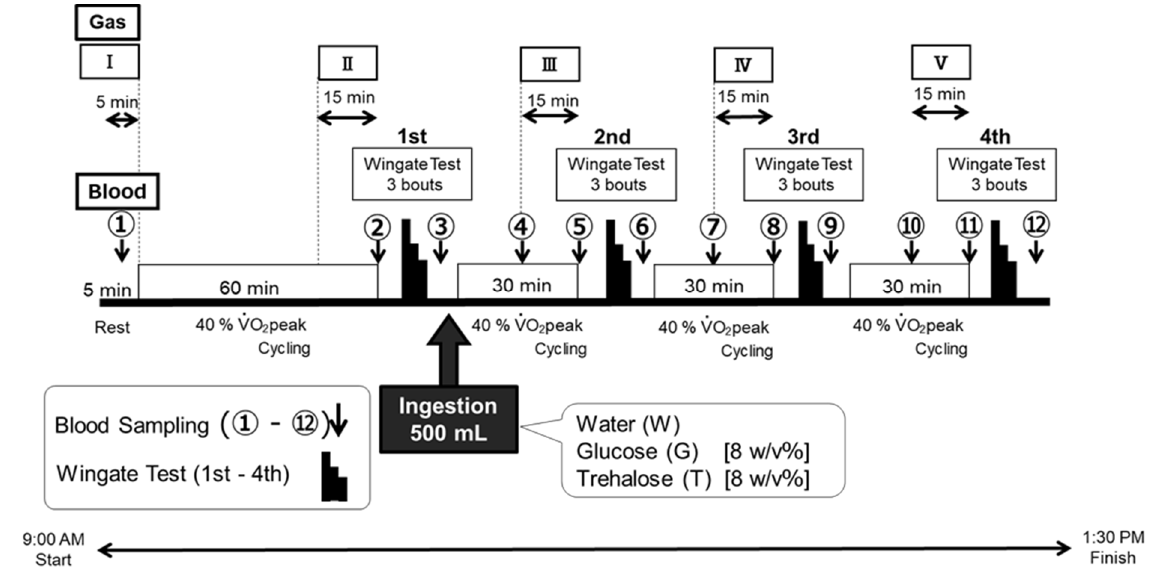
Figure 1. Experimental design. This cycling exercise protocol is a combination of constant-load exercise and the Wingate . test. The intensity of the constant load was set at 40% VO 2 peak for 60 min and 30 min × 3 times. A total of four sets of the Wingate test (30-s × 3 times) were performed. After the 1st Wingate test, the participants ingested a trial drink. Expired gas was collected at rest (I) and in the latter 15 min of the 60 min and 30 min constant-load exercise (II–V). The 12 points ( indicated blood sample collection, RPE measurements, and Borg scale